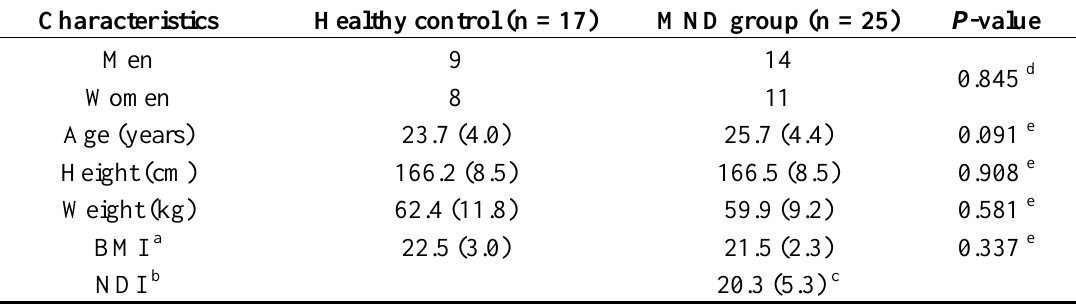
Table 1. Demographic data of healthy and MND